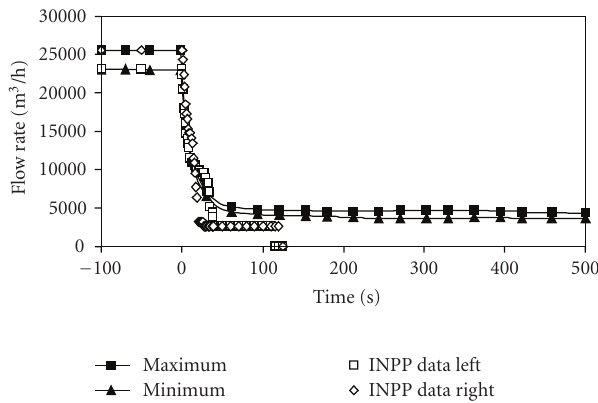
Figure 3: Loss-of-all-MCPs event. Coolant flow rate through one MCC loop.